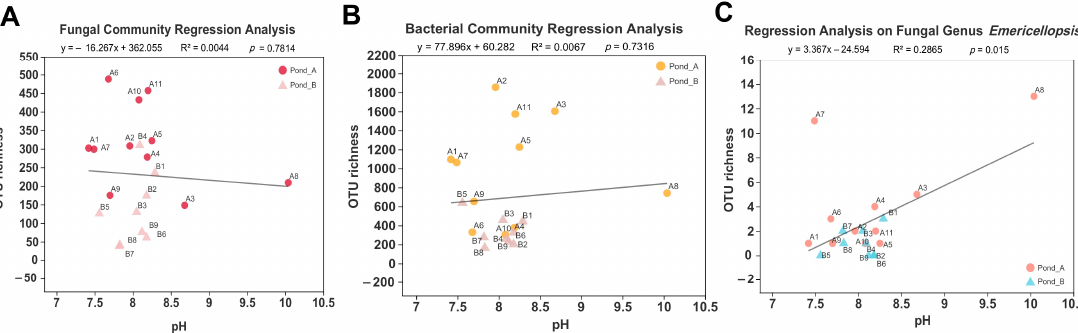
Figure 9. Linear regression between pH value and fungal OTU richness ( A ), bacterial OTU richness ( B ), and richness of OTU belonging to the fungal genus Emericellopsis ( C